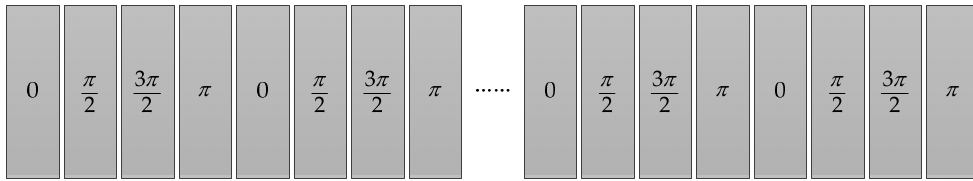
Figure 5. Phase arrangement of shutter ‐ shaped Moiré fringe signals received by photoelectric device. Linear errors led to the phases of Moiré fringe signals being 0, , and